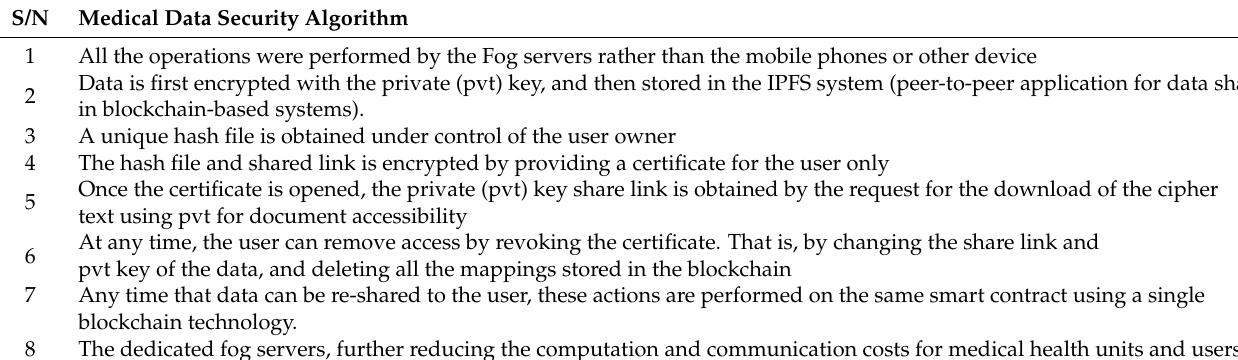
Figure 4. Internal process flow of the medical data security at the fog layer. Table 1. Workflow of the proposed model for ensuring medical data security at the fog